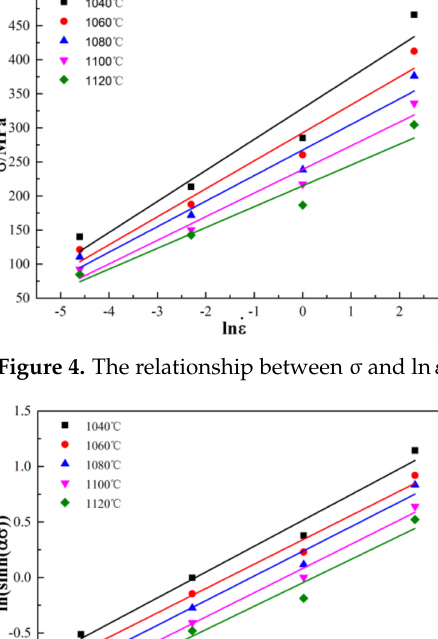
Figure 3. The relationship between ln σ and ln